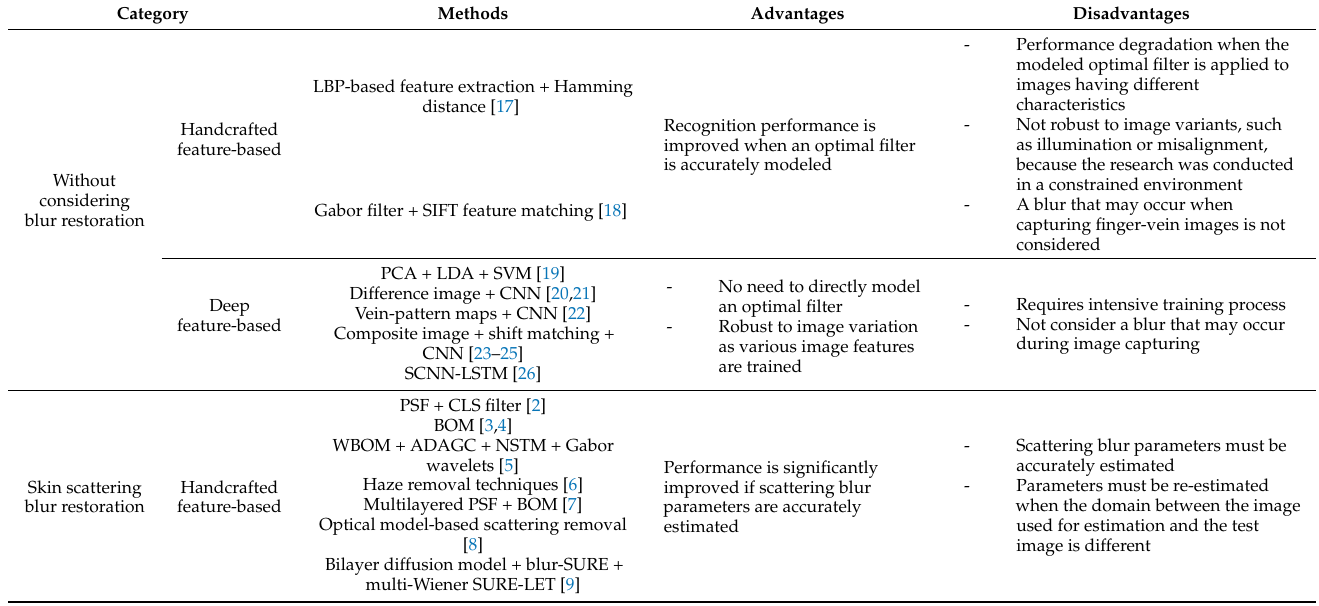
Table 1. Comparisons of the previous and proposed finger-vein image restoration methods. Category